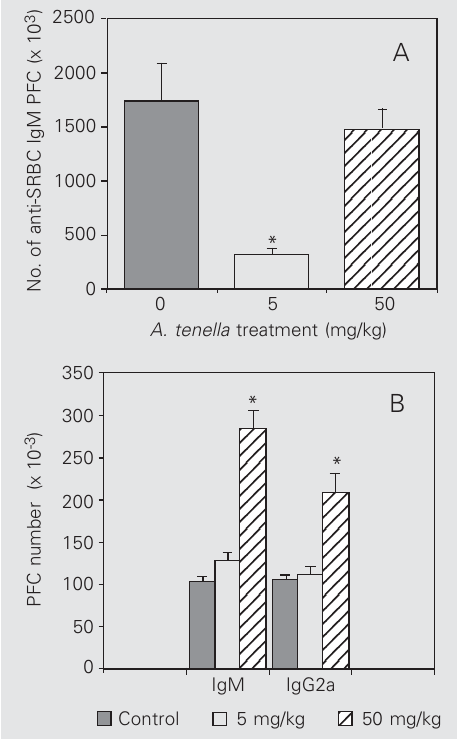
Figure 1. Effect of Alternanthera tenella extract (5 and 50 mg/kg) on IgM and IgG2a production assayed by the plaque-forming cell (PFC) assay. A , Mice immu- nized with sheep red blood cells (SRBC), and B , mice treated with 10 µg LPS 48 h after A. tenella treatment. Data are re- ported as means ± SEM for 10 animals. *P < 0.001 compared to control (Student t